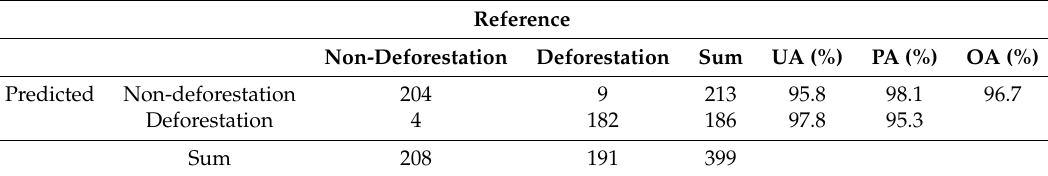
Table 3. Error matrix between reference data and the detection result of the proposed algorithm.